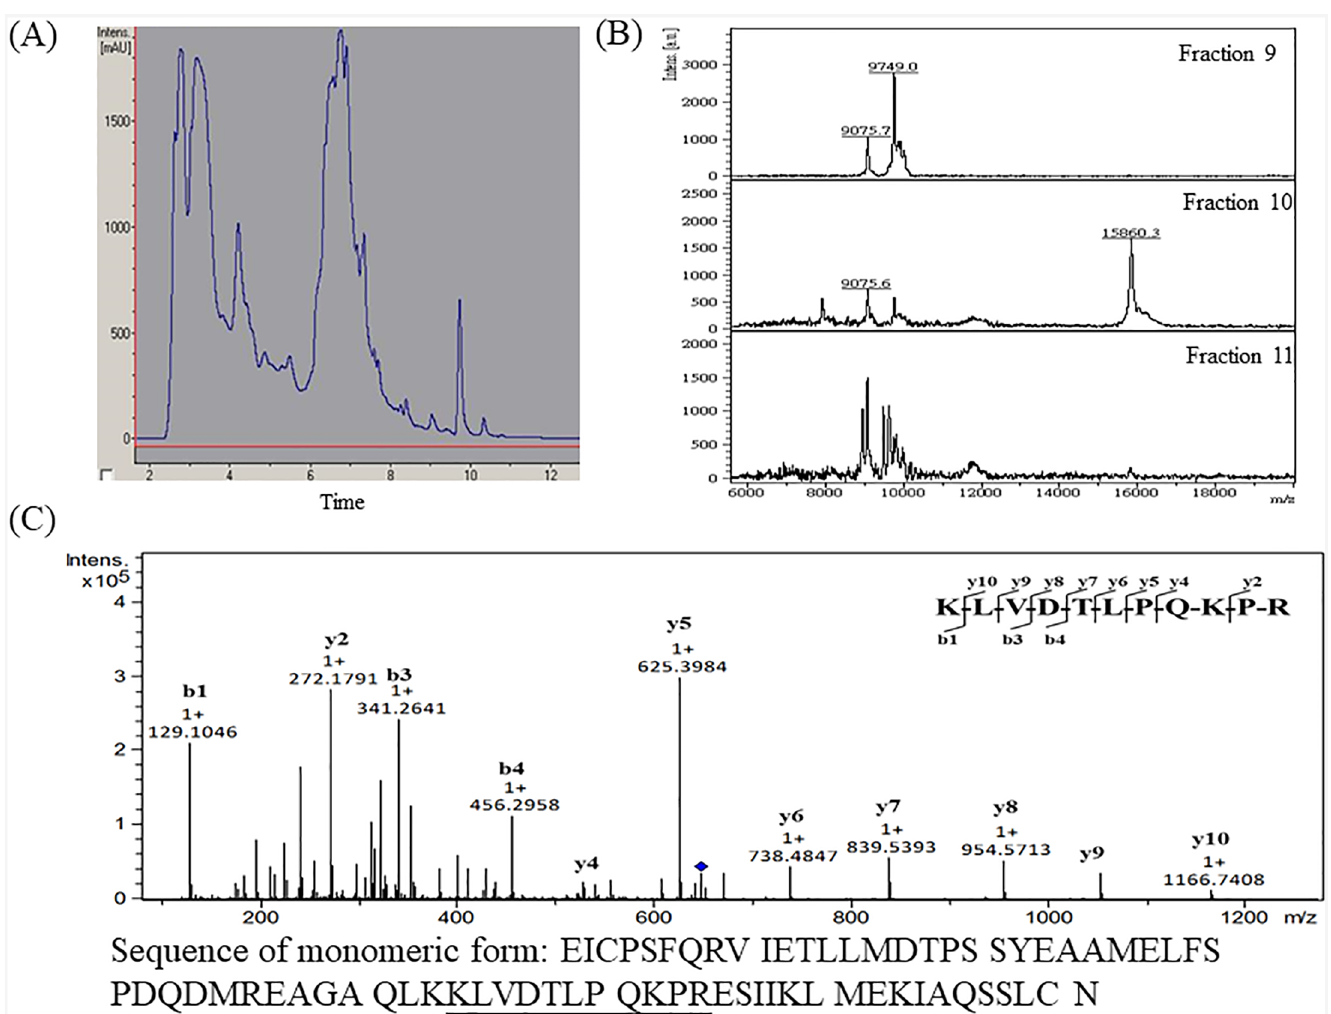
Fig 5. (A) Representative LC-UV chromatogram of urinary proteins from a DM-NP subject. The eluent was collected at 60-s intervals. (B) MALDI-TOF MS analysis of LC subfractions 9, 10, and 11. The marker peak of m/z 15860 was found in fraction 10. (C) Identification of the corresponding peptide of the m/z 647.91 peak by nanoLC-MS/MS. The sequence of CC16 was shown and the identified peptide sequence was